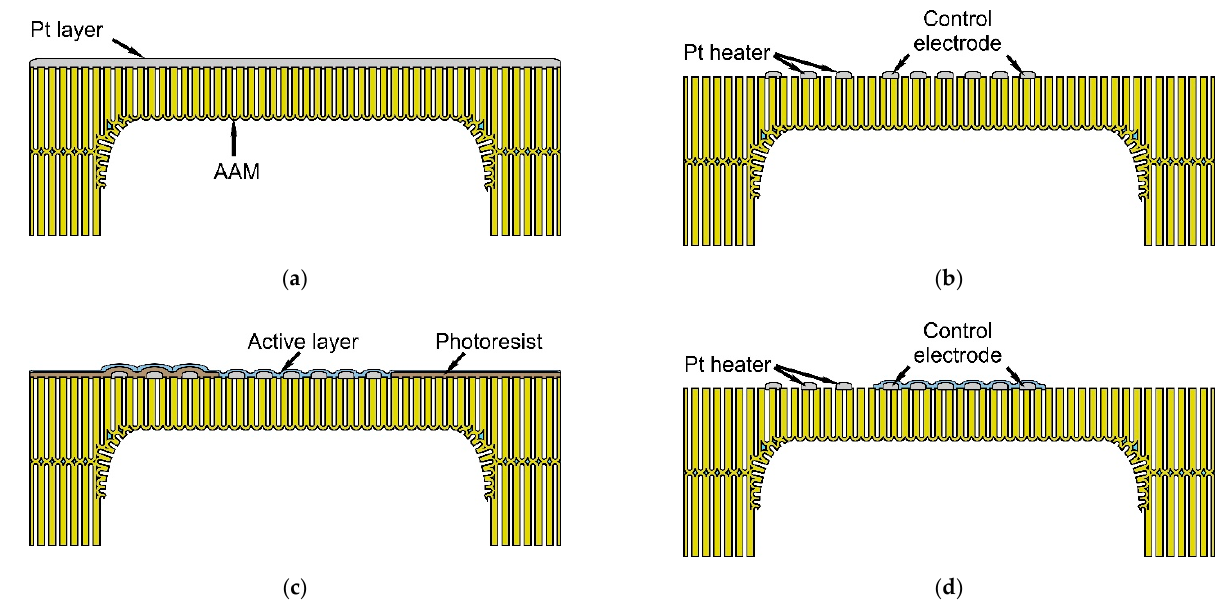
Figure 3. Schematic steps for the manufacture of the profiled substrates with thin membranes. ( a ) Magnetron sputter deposition of platinum layer of thickness 0.45 μ m. ( b ) Ion-beam etching of platinum and formation on heater topology. ( c ) Coating of double dielectric layer SiO 2 /Si 3 N 4 and ionic layering of multicomponent gas-sensitive layer of Sn x Bi k Mo y O z . ( d ) Formation of system measuring electrodes.